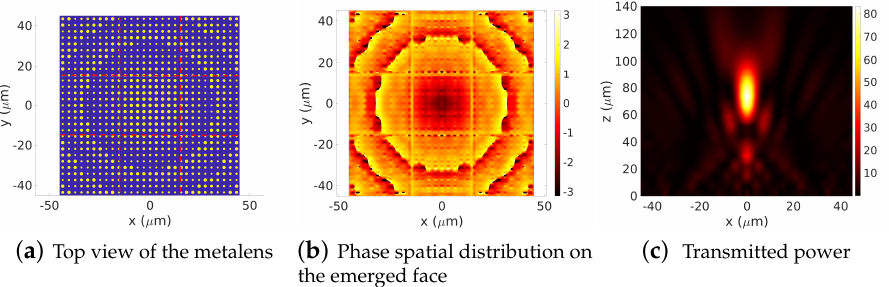
Figure 9. Forward simulation of a metalens consisting of sub-wavelength dielectric nanorodes with different cross-section. Power distributions of the focusing spot in the ( x , y = 0, z ) plane, λ = 7 µ m, z s = 10 λ , domain Ω = 12.8571 λ × 12.8571 λ = 3 × 3 sub-cell Ω ij , h = 5.57 µ m, materials: dielectrics